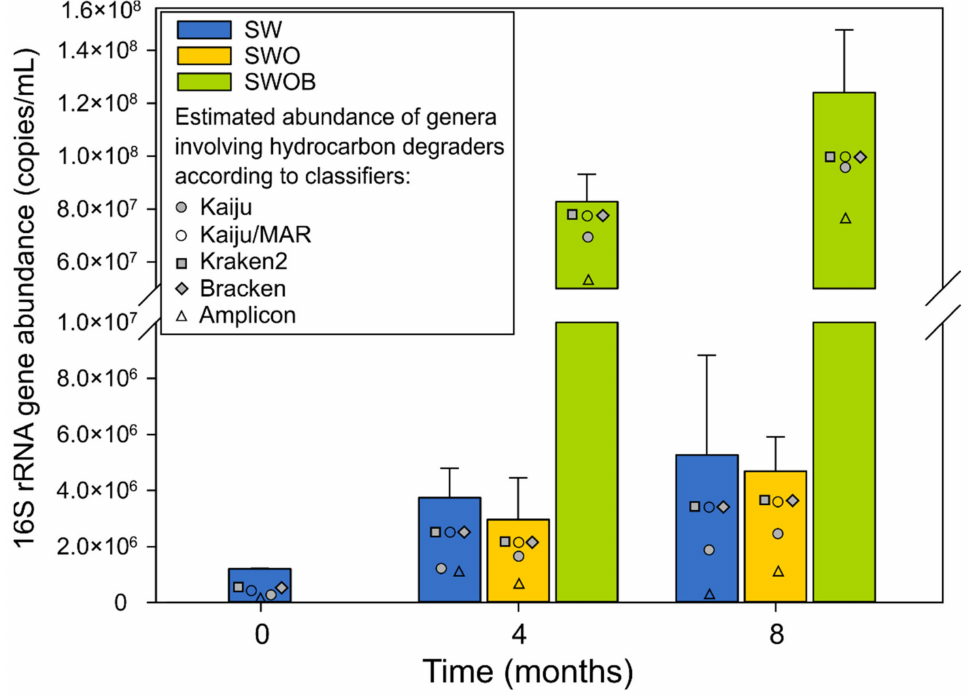
Figure 2. The average abundances and SD ( n = 2) of summarized bacterial and archaeal 16S rRNA genes as well as estimated abundances of genera containing oil hydrocarbon degraders based on